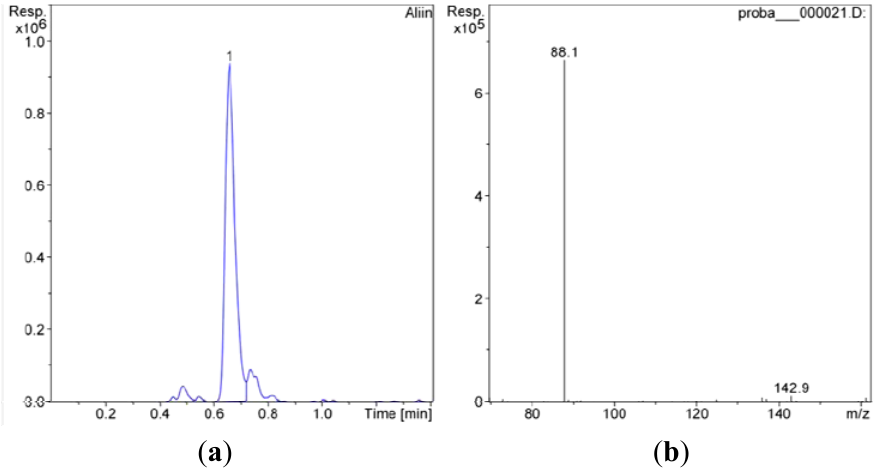
Figure 5. ( a ) The chromatogram of A . obliquum extract; ( b ) MS-MS spectra of